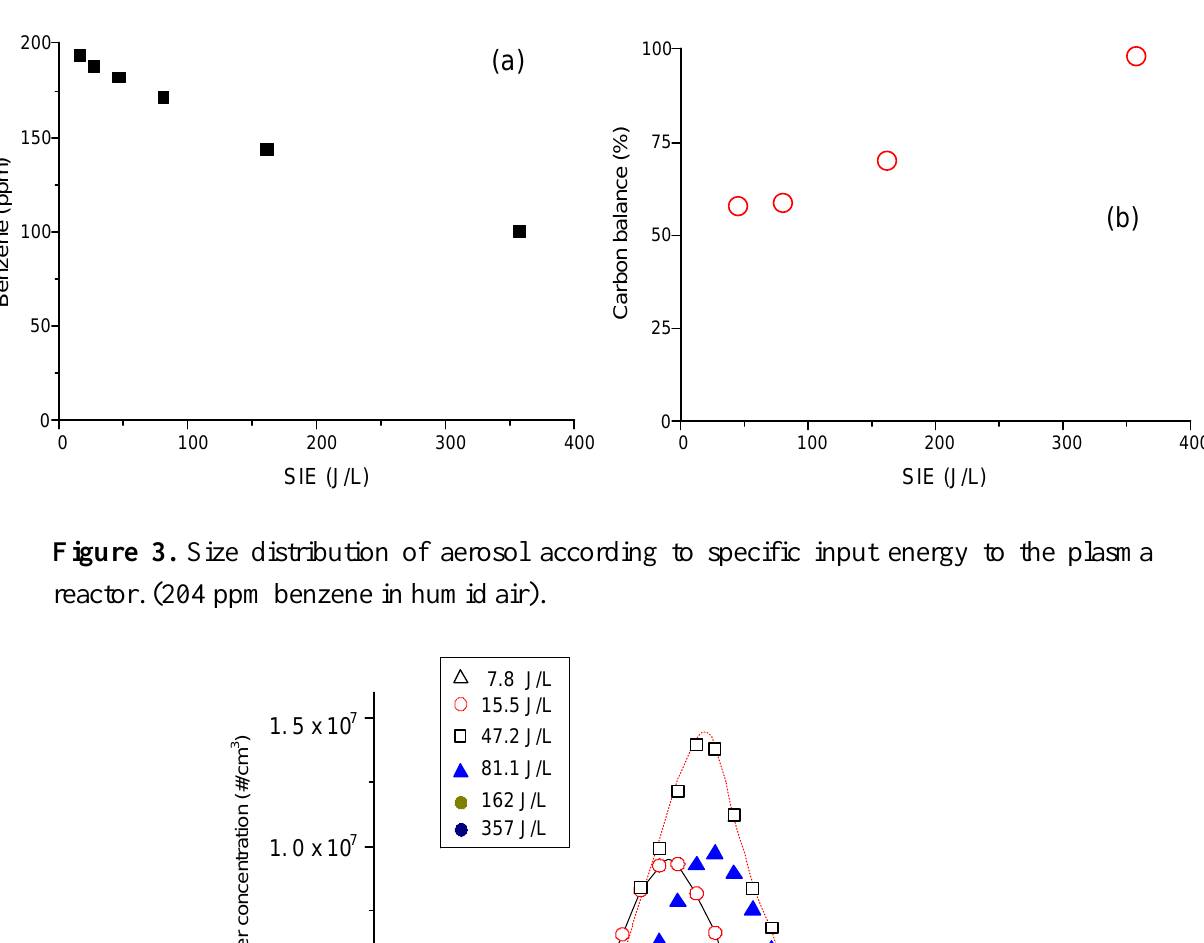
(b) carbon balance.